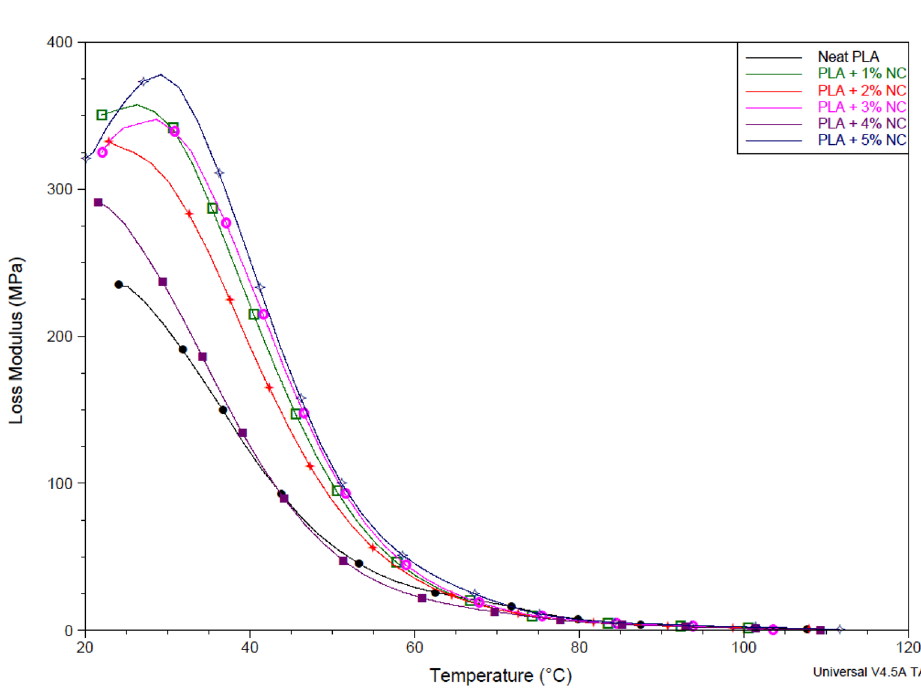
Figure 6. Loss modulus of unfilled and nano-CaCO 3 reinforced polylactic acid bioplastic